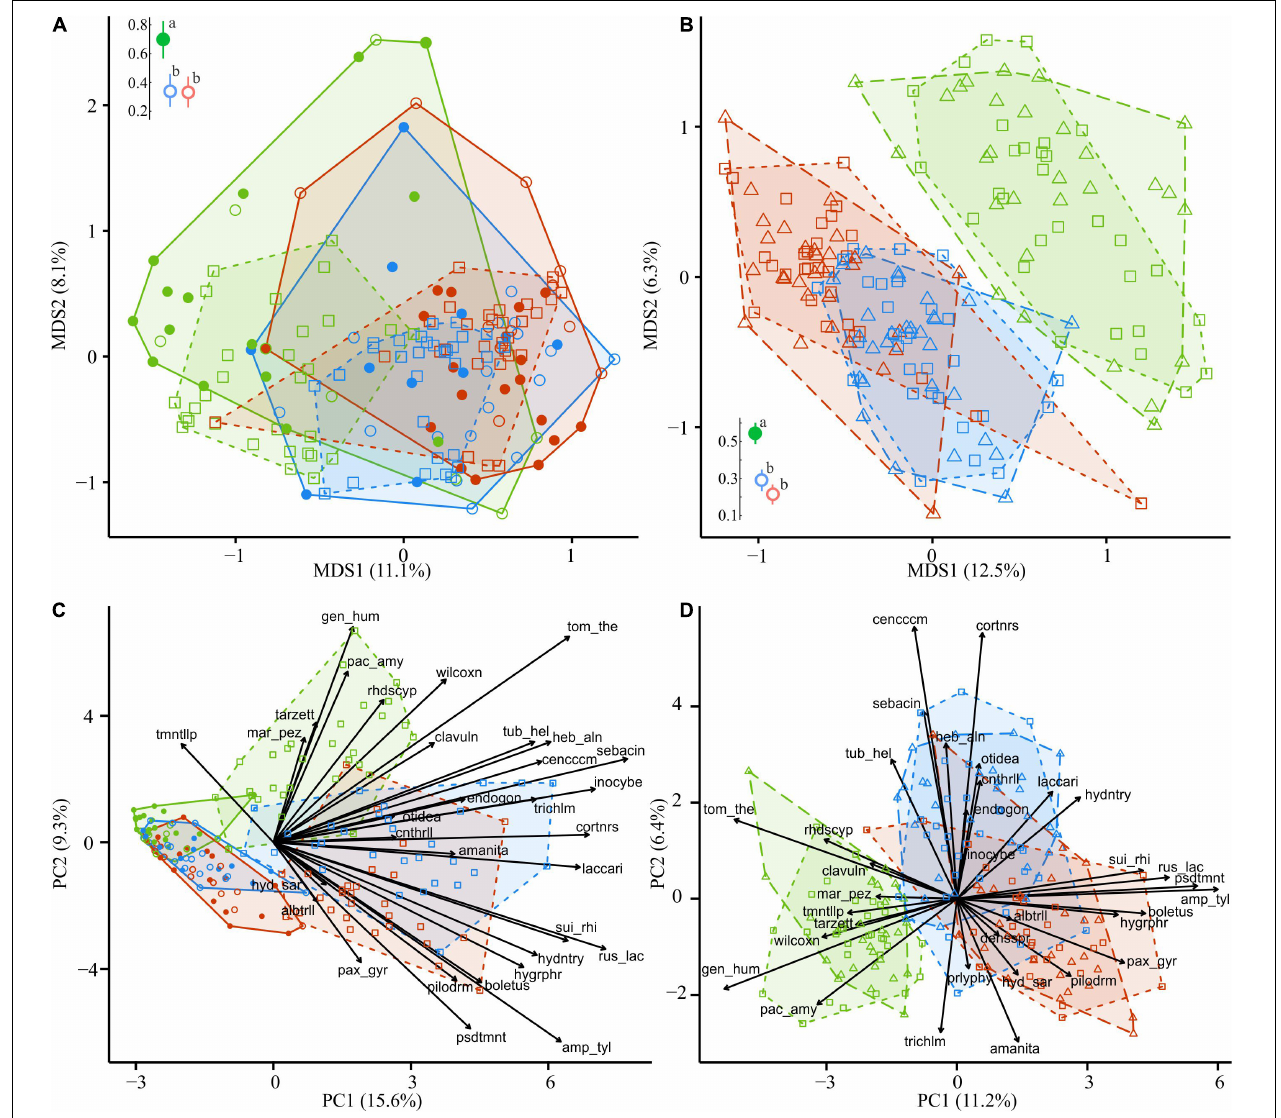
FIGURE 8 | Compositional dissimilarity of EcM fungi from the areas with different levels of industrial pollution (green, UP area; blue, MP area; red, HP area). Filled circles in (A,C) denote fir wood; empty circles, spruce wood. Triangles in (B,D) denote CWD-influenced litter. CWD-uninfluenced litter is shown with squares. Average dissimilarity values with 95% CI are shown next to ordination diagrams in (A,B) filled dots indicate statistically significant compositional divergence between microhabitats within an area (PERMANOVA test, p < 0.05); different letters indicate significant effect of area on dissimilarity (Tukey’s test, p < 0.05). The arrows indicate the increase in EcM lineage relative abundance toward an area and a substrate. EcM, ectomycorrhizal; UP, unpolluted; MP, moderately polluted; HP, heavily polluted; CWD, coarse woody